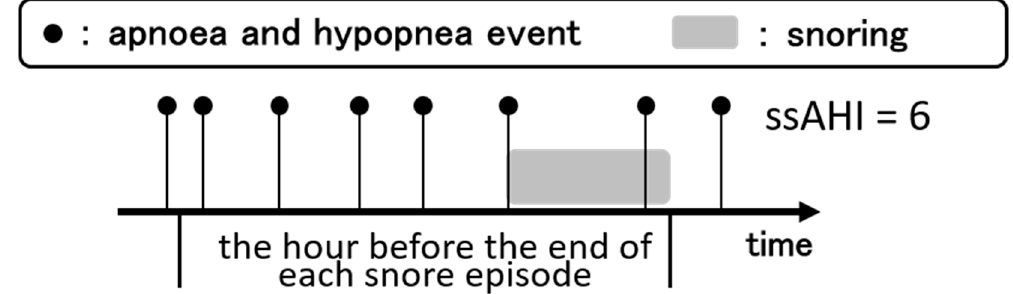
Figure 2. The snore-specific apnoea-hypopnea index (ssAHI) was defined as the number of apnoea and hypopnea events during the hour before a snore episode.